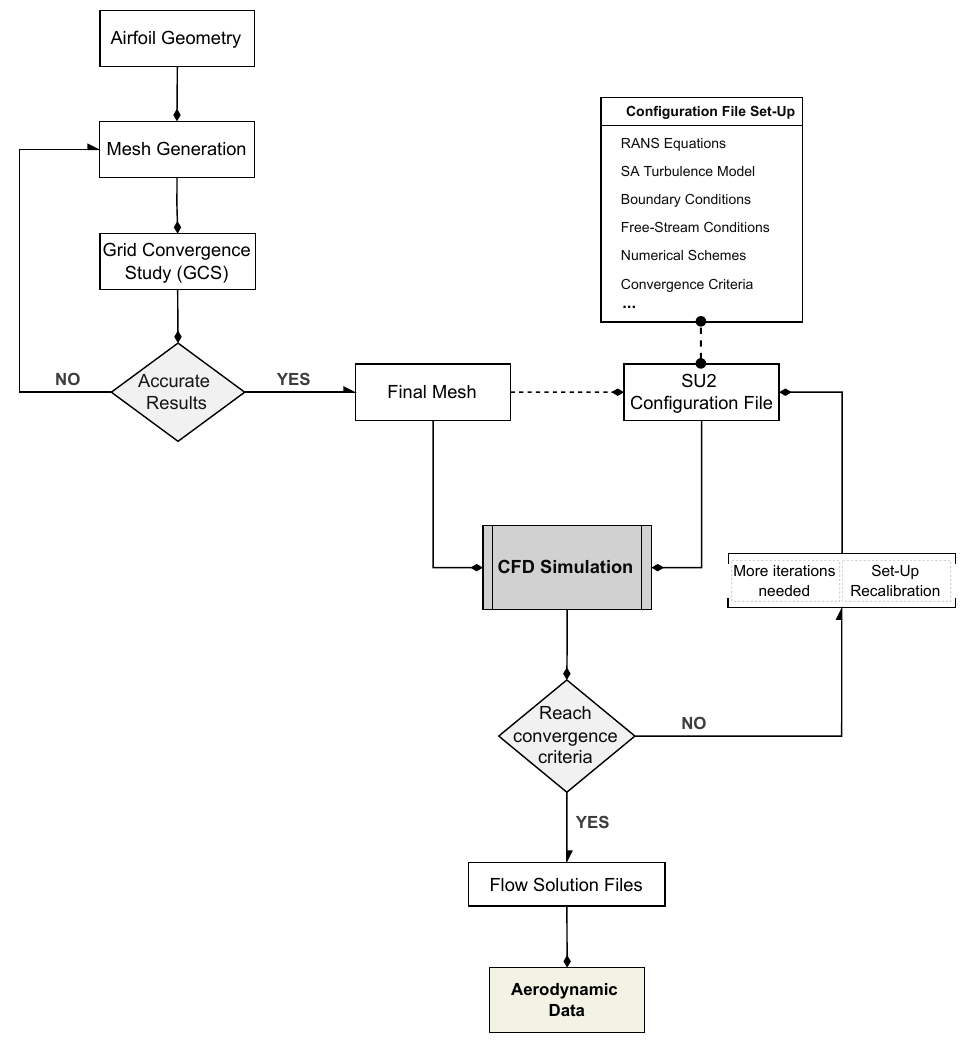
Figure 6. Baseline simulation